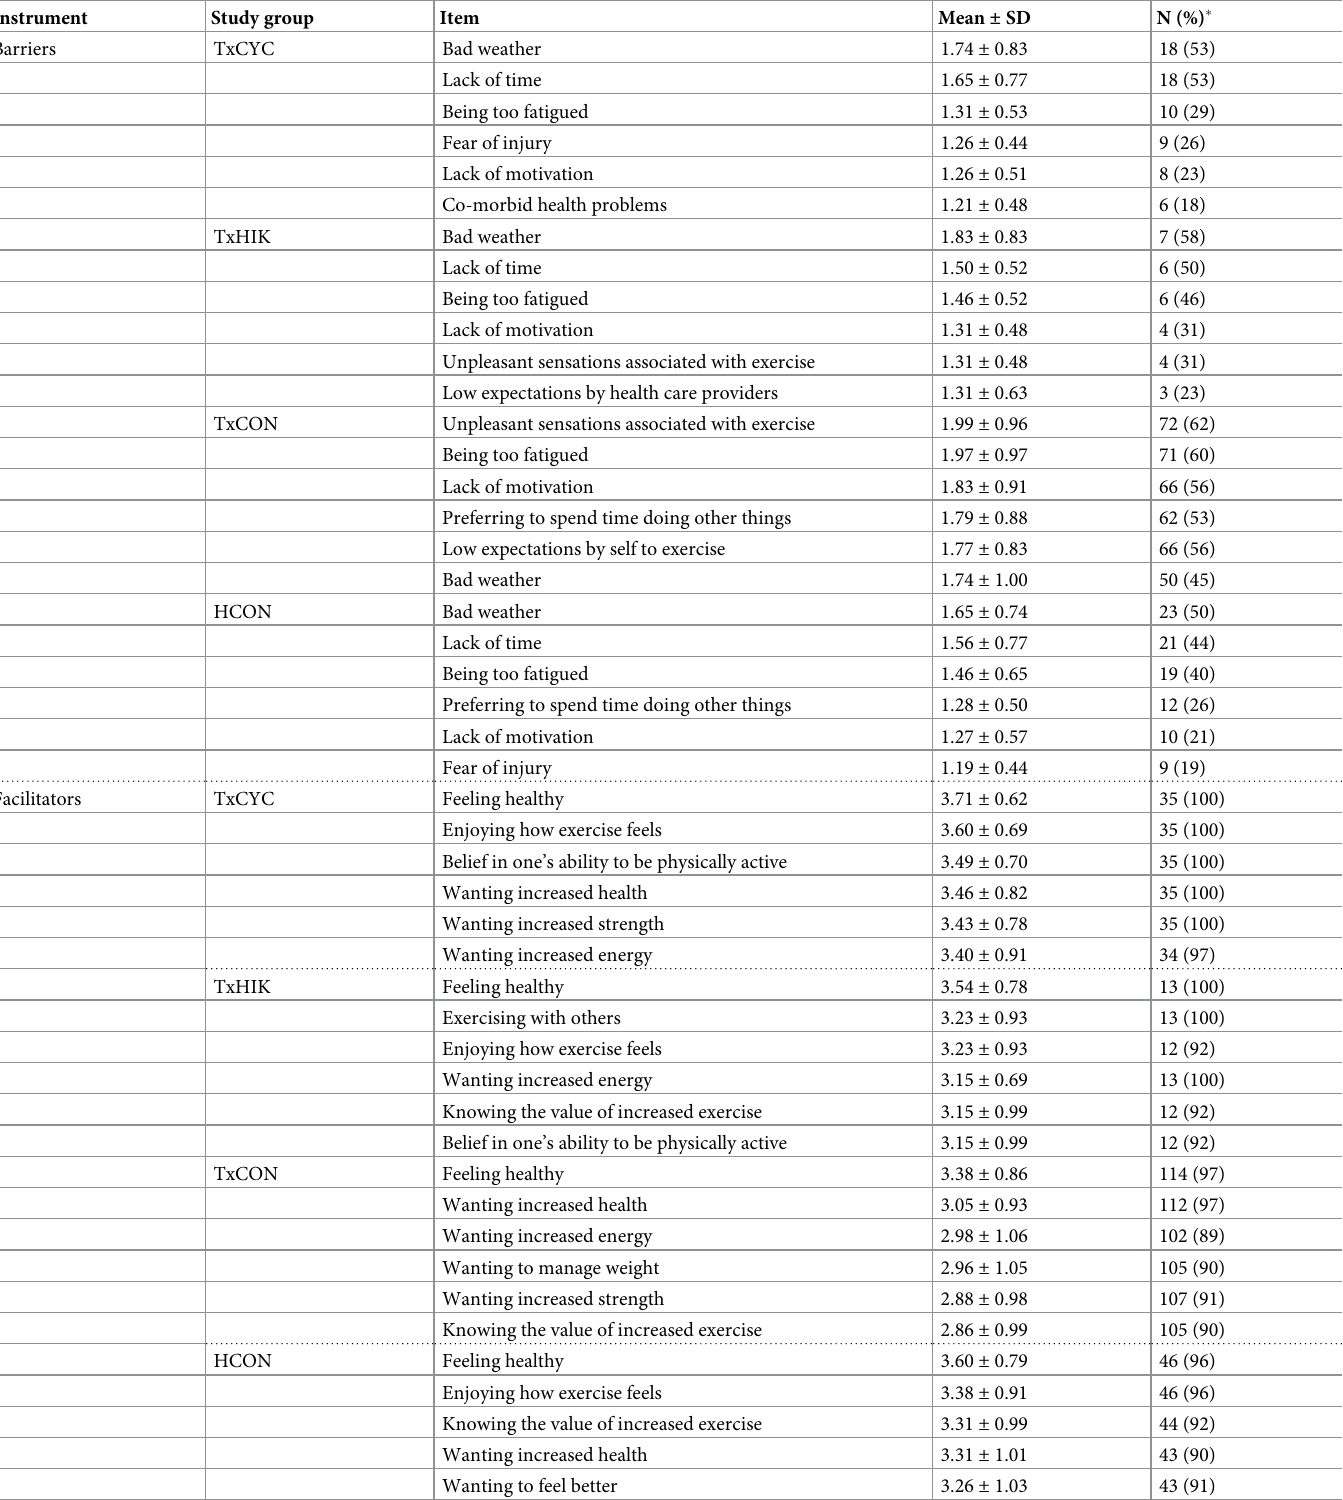
Table 2. First six barriers and facilitators to physical activity in each of the study groups.